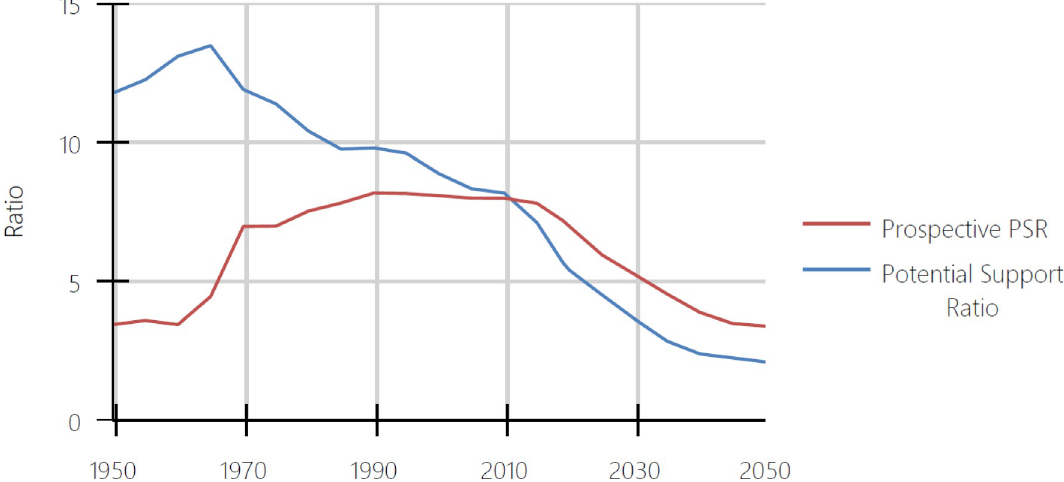
Fig 2. Potential support ratio and prospective potential support ratio, China, 1950–2050. Source: United Nations, Profiles of Ageing 2019 [1].